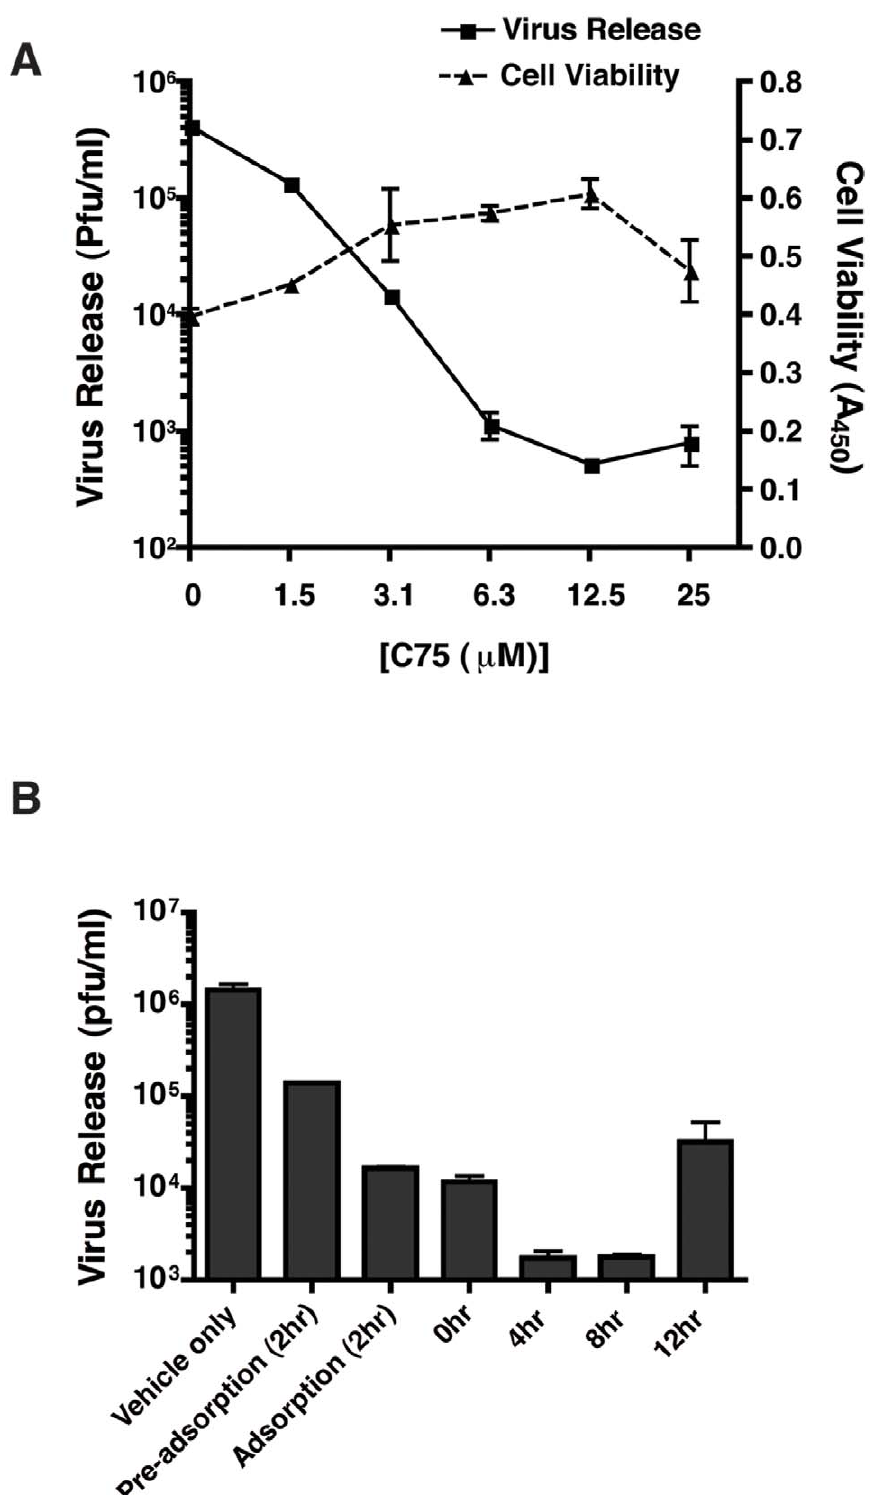
Figure 1. C75, a fatty acid synthase inhibitor disrupts DENV replication in mosquito cells. A. C6/36 mosquito cells were infected with DENV at an MOI of 3. Following adsorption of the virus, the indicated concentrations of C75 were added to the cells in the overlay media. A vehicle control of ethanol only was also included. Virus release was assayed by plaque assay 24 hr post-infection. Cell viability was assayed using the Quick Cell Proliferation Kit (Promega) at 24 hr post-infection. B. A time course of addition of C75 in C6/36 cells infected with DENV at an MOI of 3. Cells were either pre-treated (2 hr), or treated with 6.3 uM C75 during adsorption, post-adsorption (0 hr) or at 4, 8 and 12 hr post-infection. The results represent three independent experiments. The error bars represent standard deviation of the mean.